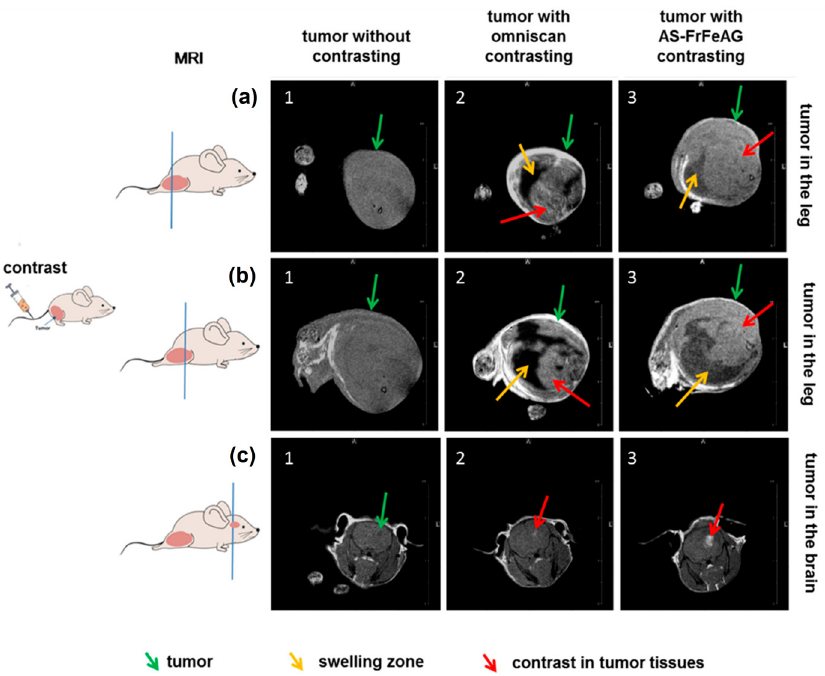
Figure 9. AS-FrFeAG functional nanoparticles used as a contrast agent for magnetic resonance imaging of tumors. A mouse with a tumor transplanted in the right leg ( a , b ) or brain ( c ) imaged without a contrast agent (1), with OmniScan as a contrast agent (2), or with AS-FrFeAG as a contrast agent (3). Reproduced from reference [36].